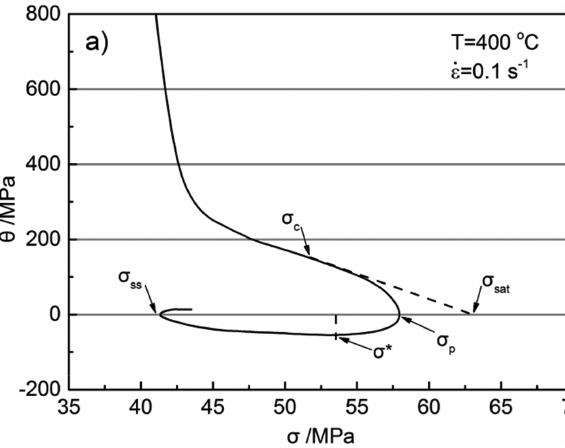
Figure 7: Relationship between θ ( θ = ∂ σ = ∂ ε ) versus σ under the deformation temperature of 400 ℃ with strain rate of 0.1s – 1